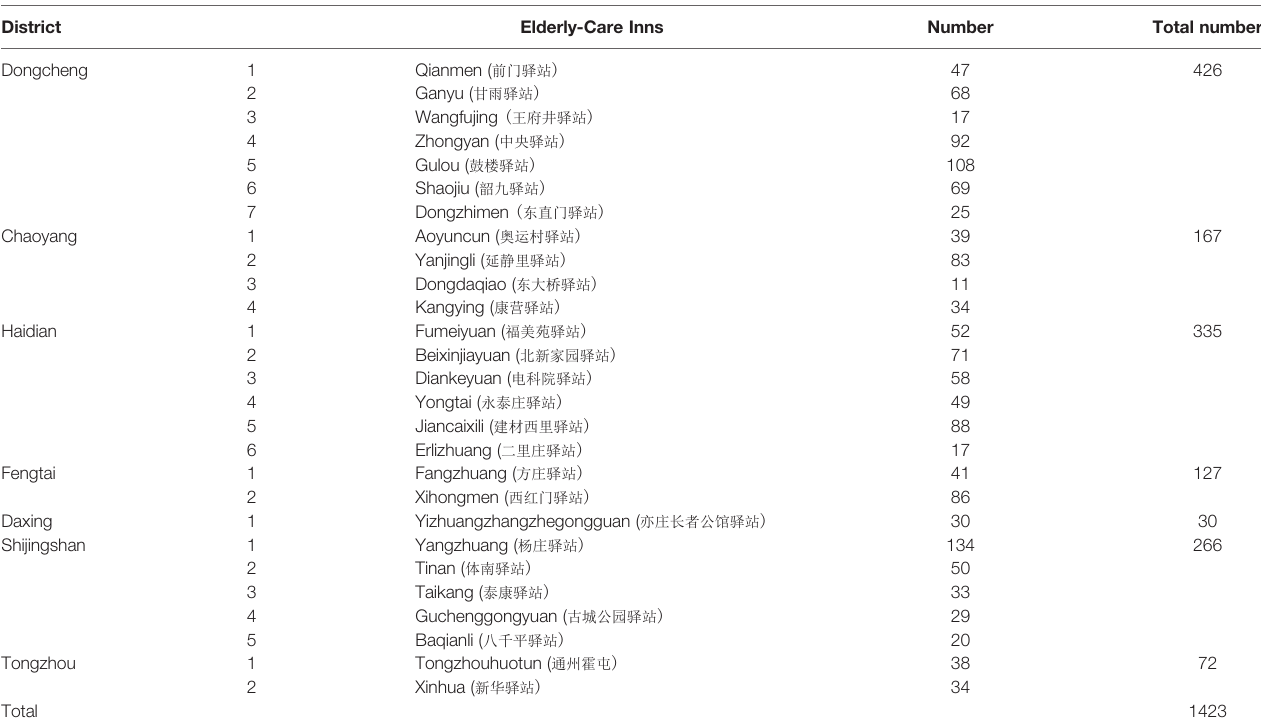
TABLE 1 | Distribution of the recruited elderly-care inns in Beijing.